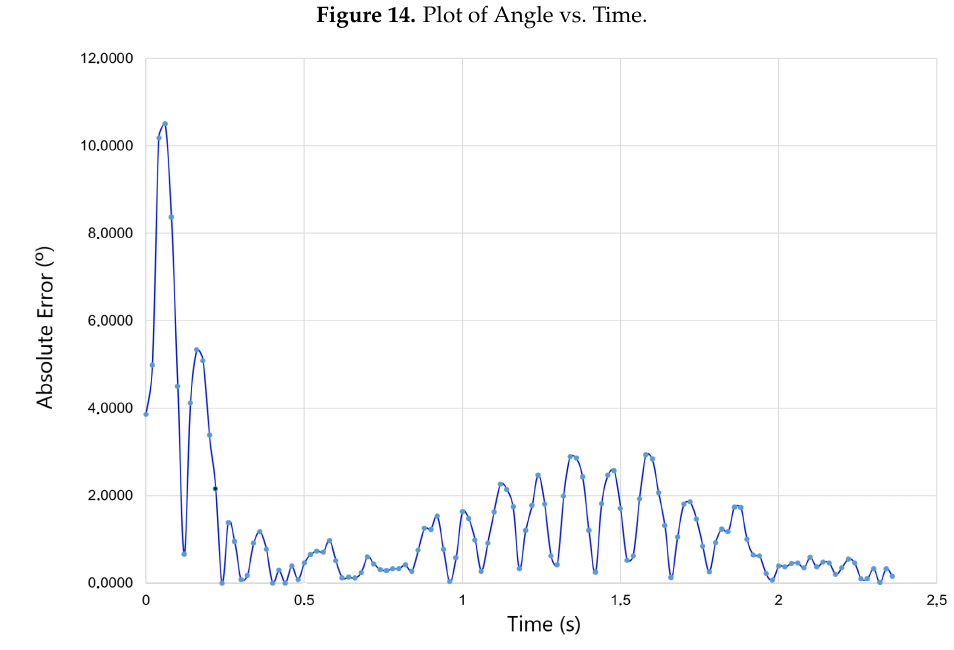
Figure 15. Absolute Error vs.